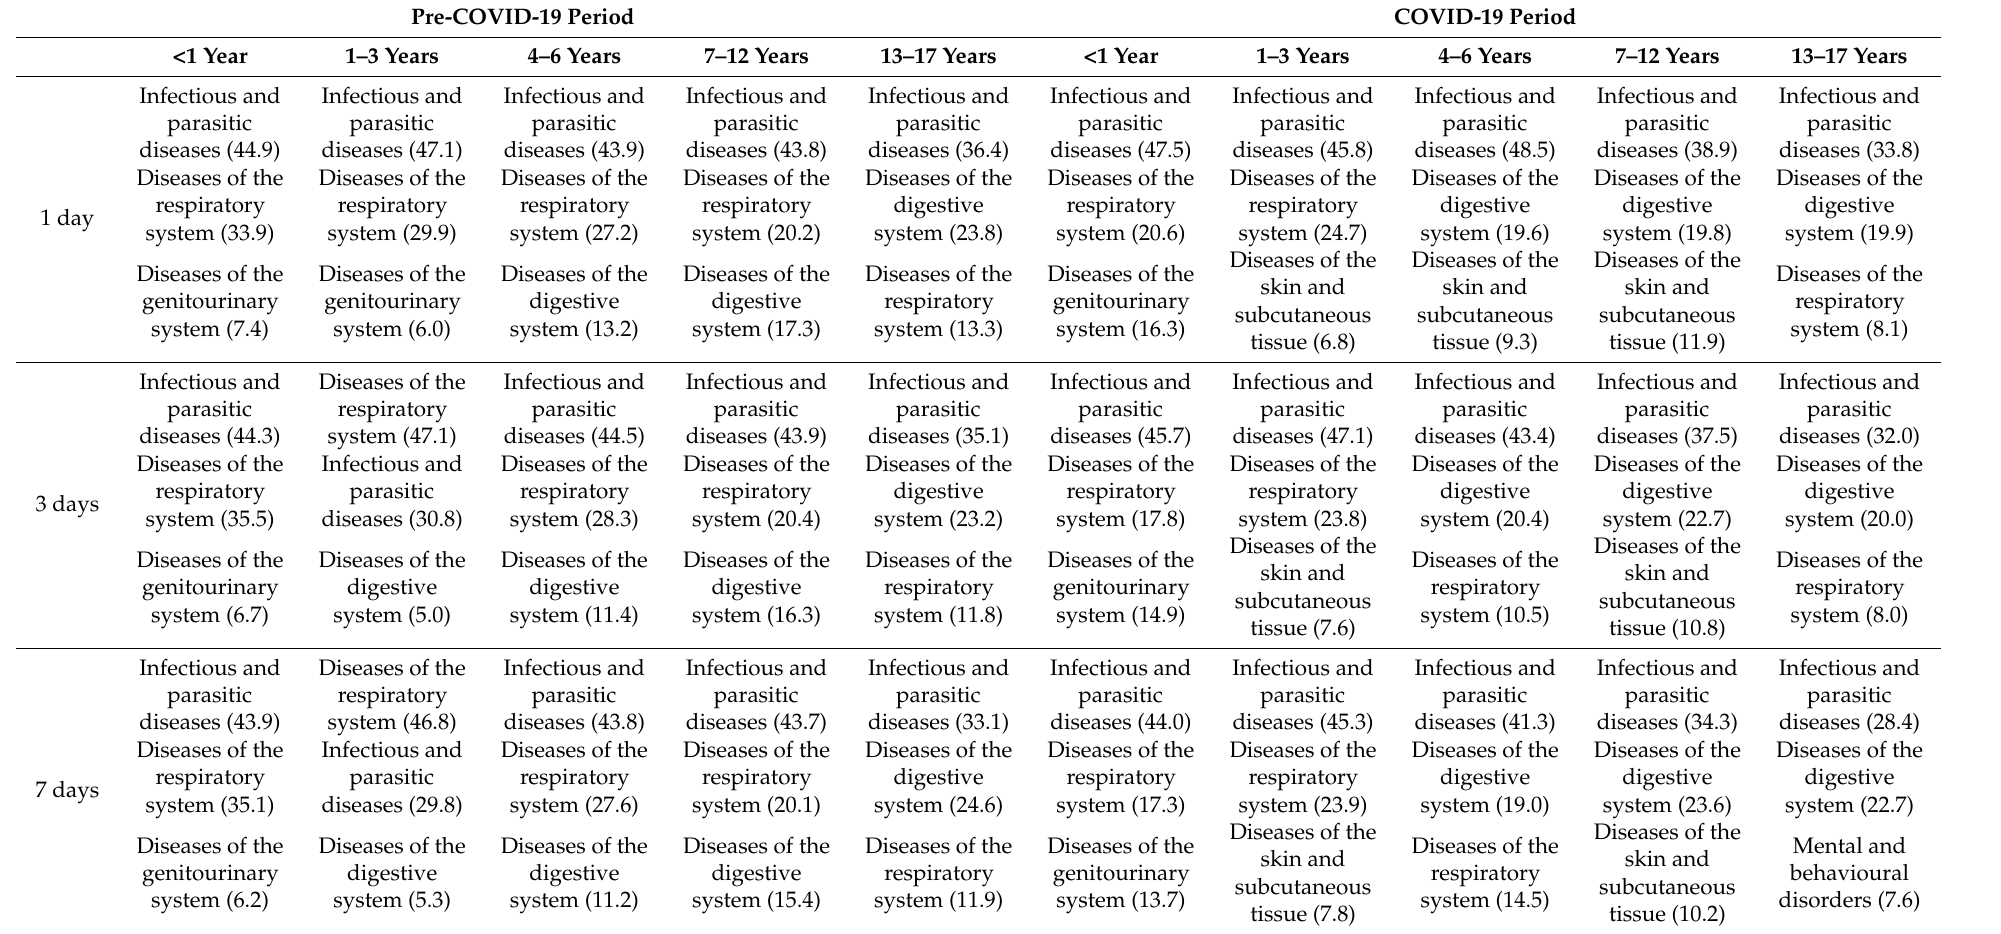
Table 2. Top three diagnoses at revisits within 1, 3, and 7 days of the first emergency department visit, stratified by age